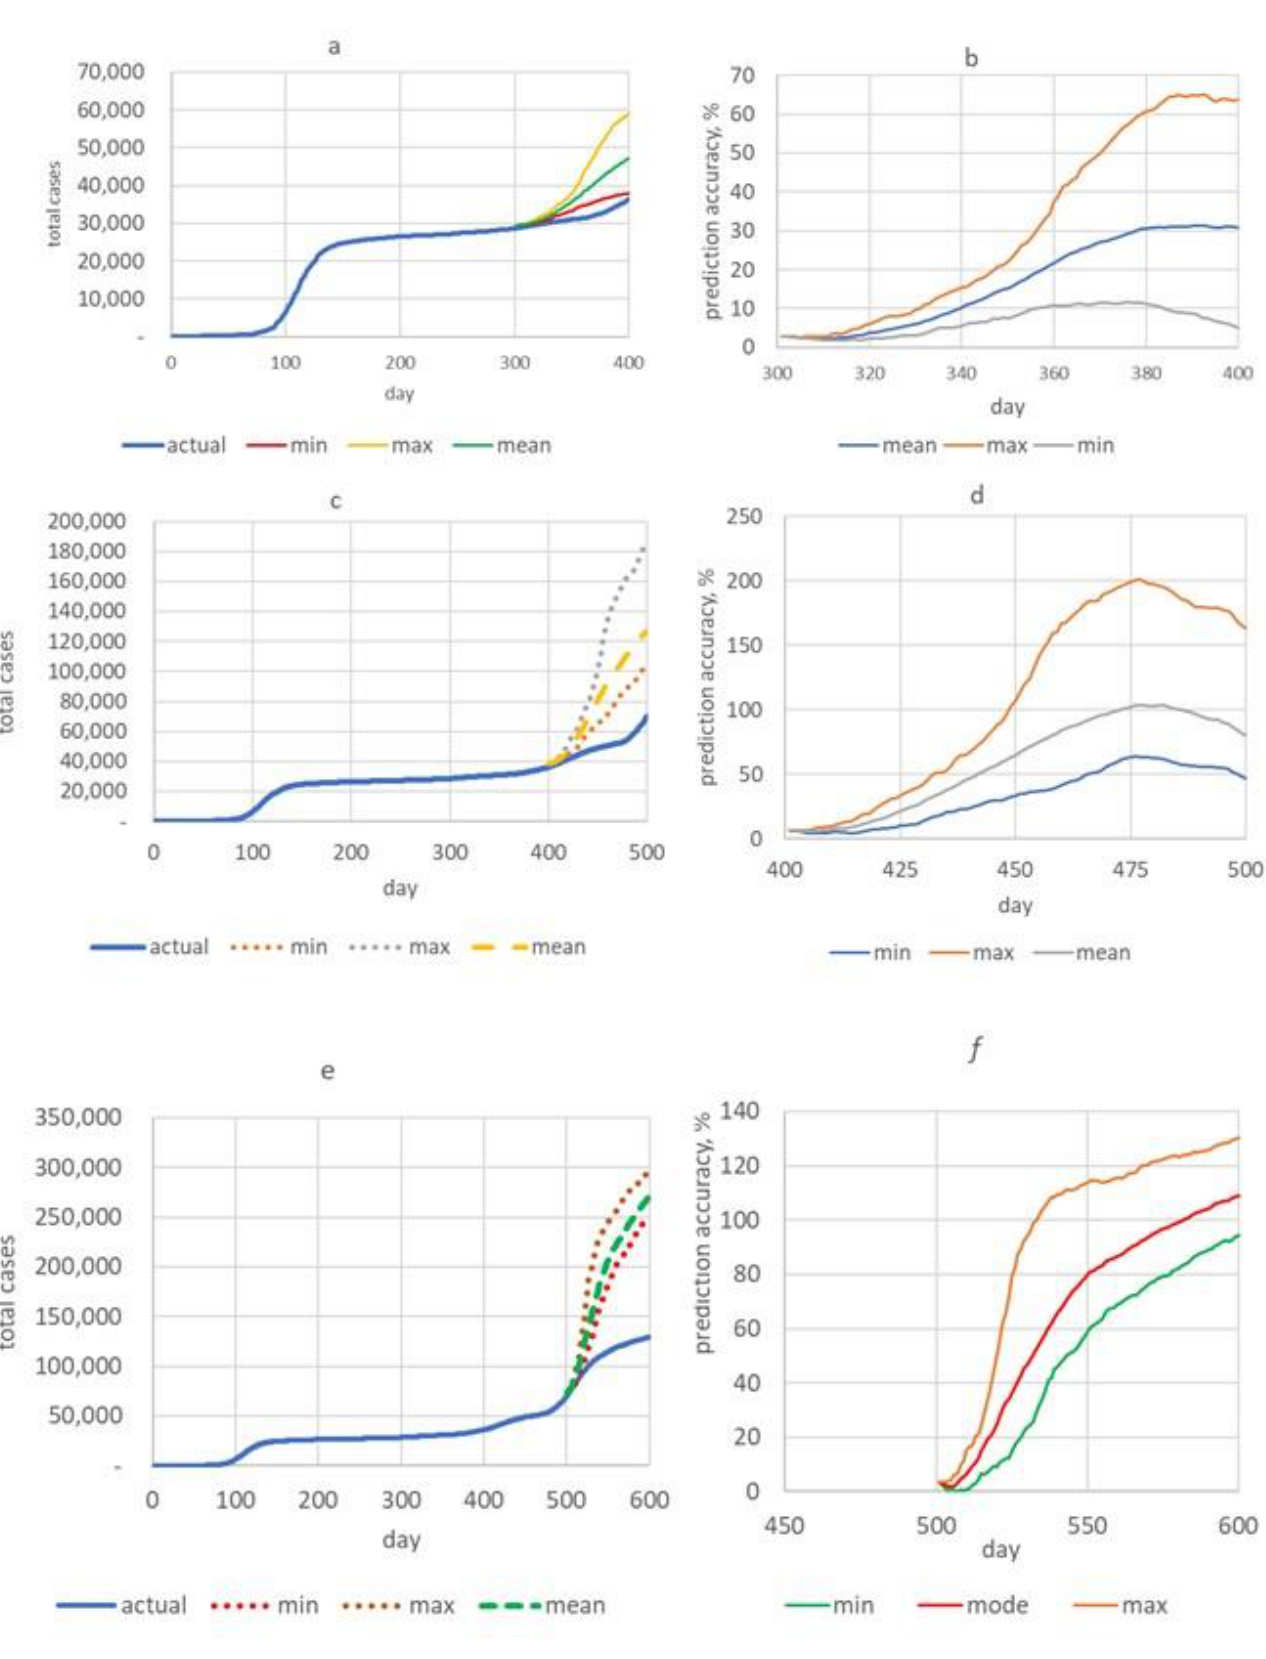
Figure 5. Forecasting total cases (left) and evaluation of forecasting accuracy APE (right). ( a , b ) First testing time frame; ( c , d ) second testing time frame; ( e , f ) third testing time frame. Green line—optimistic scenario; orange line—pessimistic scenario and red line—most likely scenario.